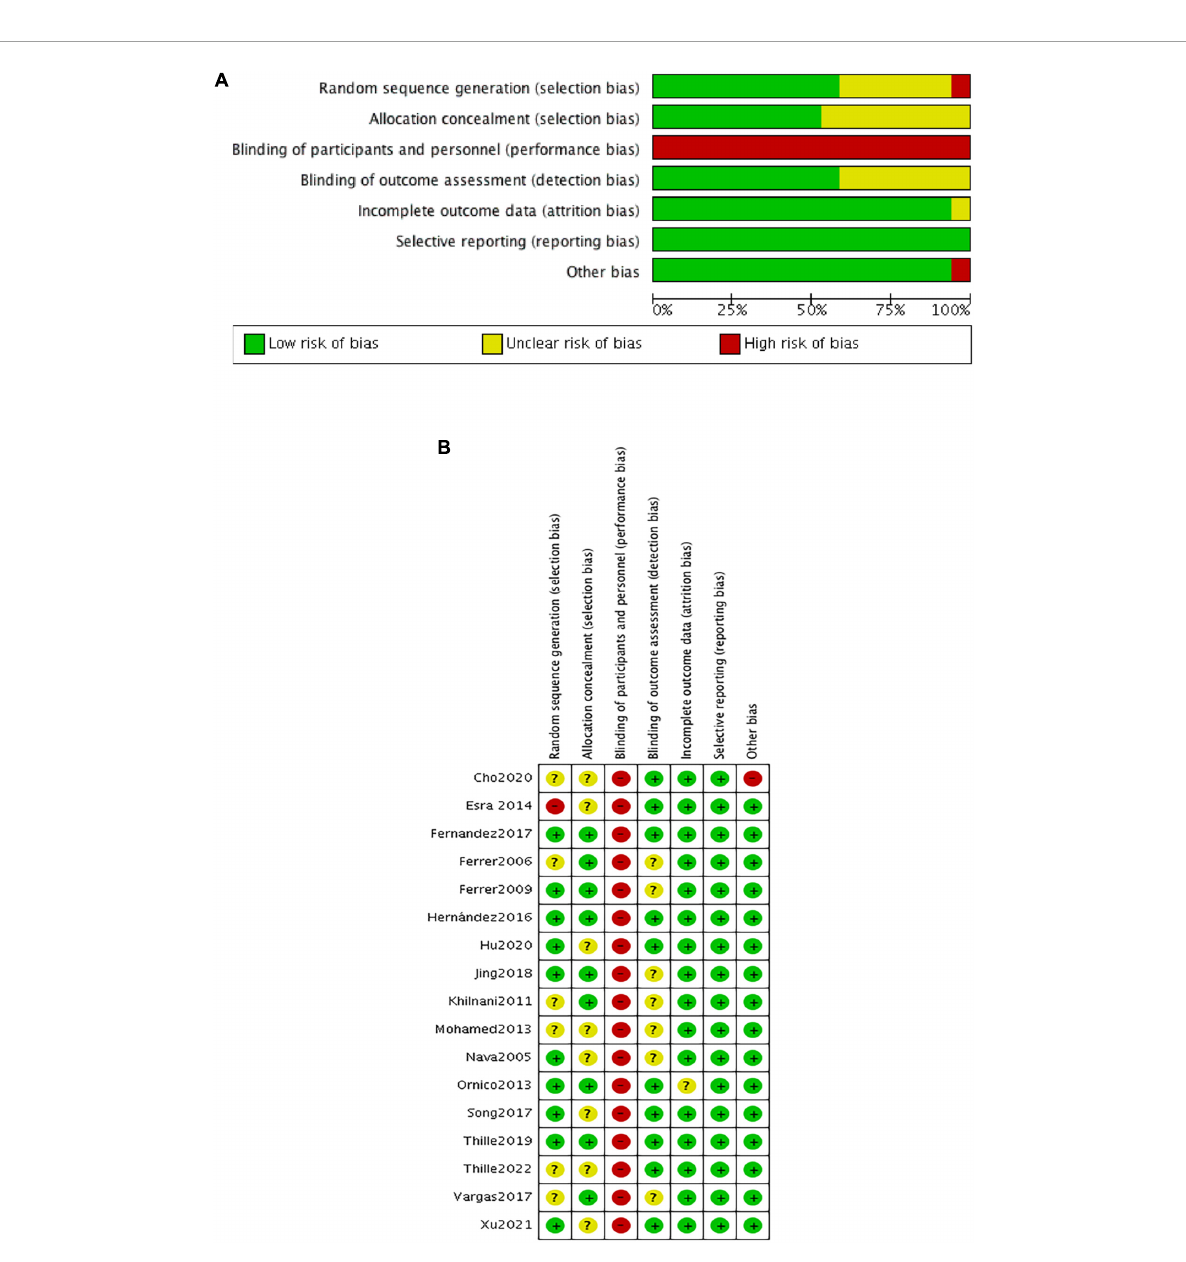
FIGURE2 Risk of bias for each comparison. (A) Risk of bias summary; (B) risk of bias